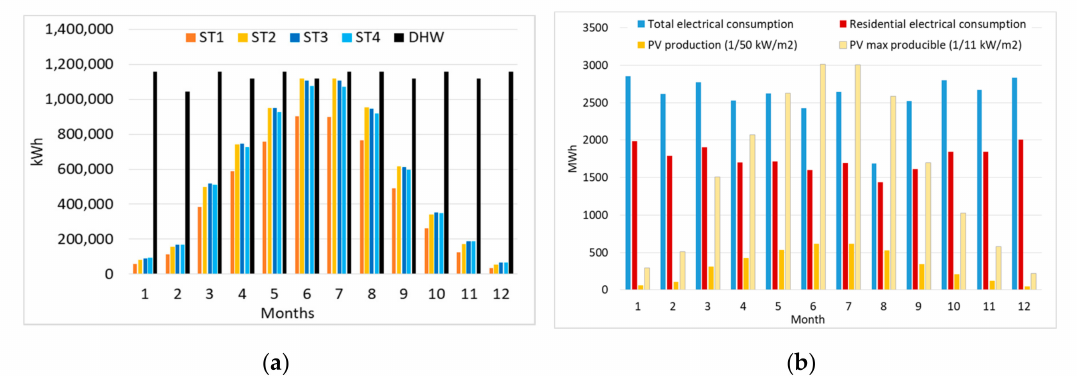
Figure 11. Solar energy technology assessment (for the 2014 year): ( a ) Comparison between domestic hot water (DHW) consumption of residential sector and solar thermal (ST) production considering four collector typologies (collectors’ annual average e ffi ciency: ST1 = 0.59, ST2 = 0.77, ST3 = 0.80, and ST = 0.79); ( b ) comparison between electrical consumption, photovoltaic (PV) production with coe ffi cient K = 50 m 2 / kW (according to the Decree 28 / 2011), and PV max producible.